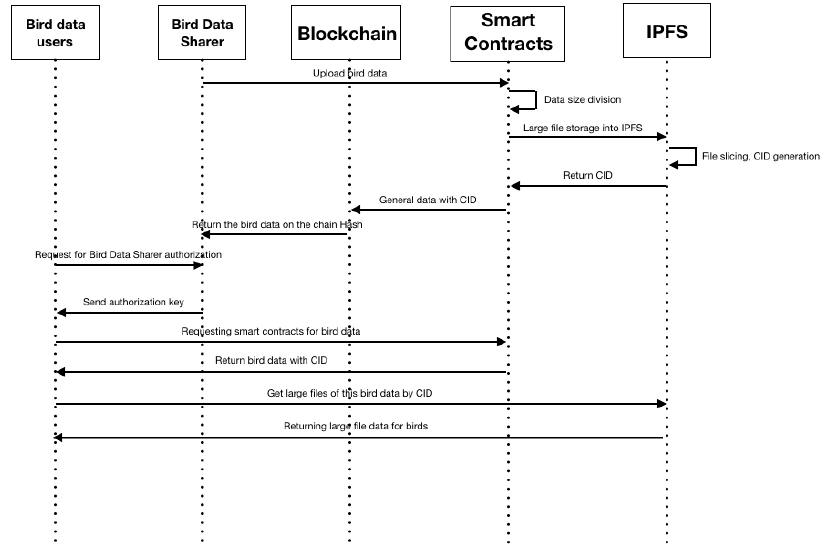
Figure 4. Blockchain and IPFS-based data sharing model for birds.